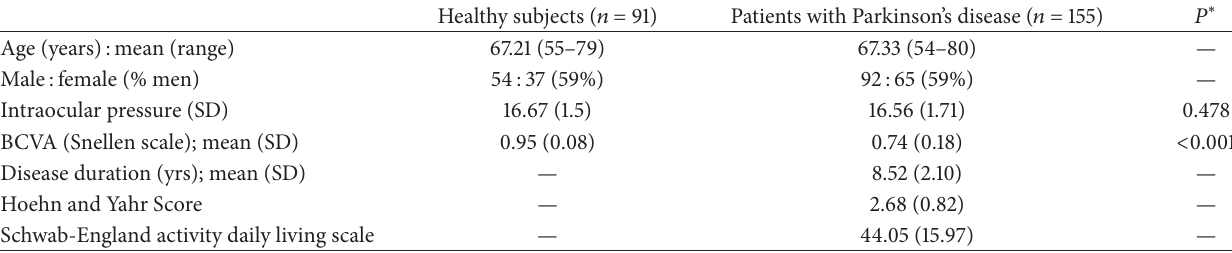
Table 1: Epidemiologic and disease characteristics of 155 patients with Parkinson’s disease and 91 healthy subjects included in the study and statistical significance of comparison between both groups ( 𝑃 ).